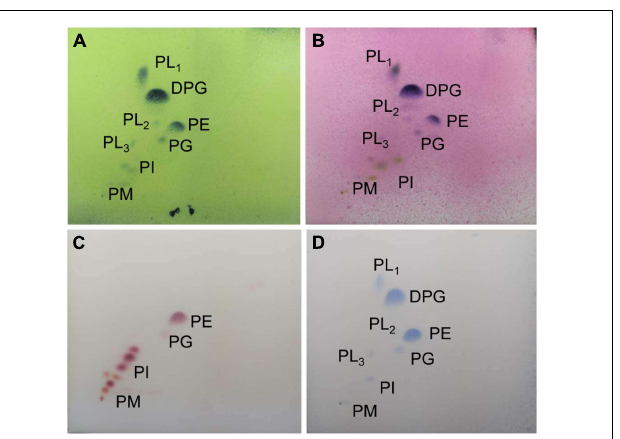
FIGURE 4 | The phospholipid profile of strain SCA2-4 T sprayed with phosphomolybdic acid (A) , a-naphthol (B) , ninhydrin (C) , and phosphate (D) . The horizontal and vertical directions were developed using the chloroform-methanol-water (65:25:4) (v/v) and the chloroform-methanol-acetic acid-water (80:12:15:4) (v/v), respectively. DPG, diphosphatidylglycerol; PE, phosphatidylethanolamine; PL1-3, unidentified phospholipids; PG, phosphatidylglycerol; PI, Phosphatidylinositol; PIM,